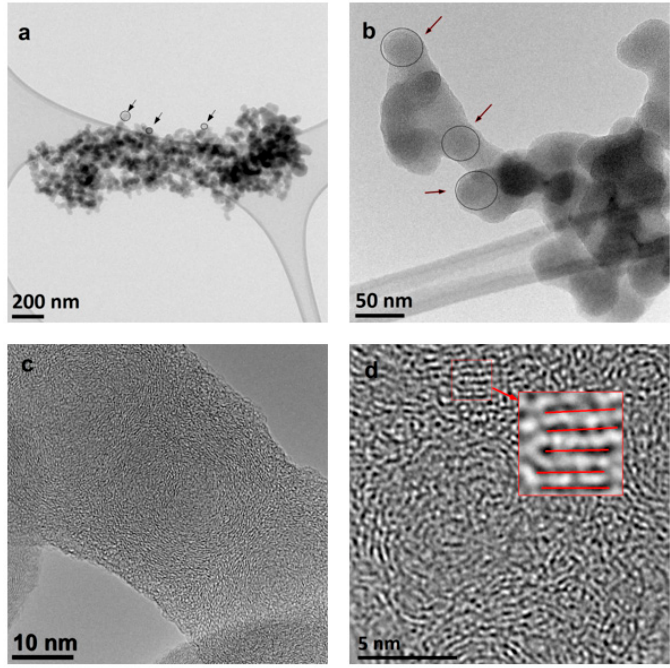
Figure 2. Multiscale organization of the young ethylene soot structure. TEM images obtained at dif- ferent magnifications, as indicated by the reported scales ( a – d ) Black arrows in ( b ) indicate spherical soot particles. Red lines in ( d ) indicate the parallel arrangement of the defected carbon layers.